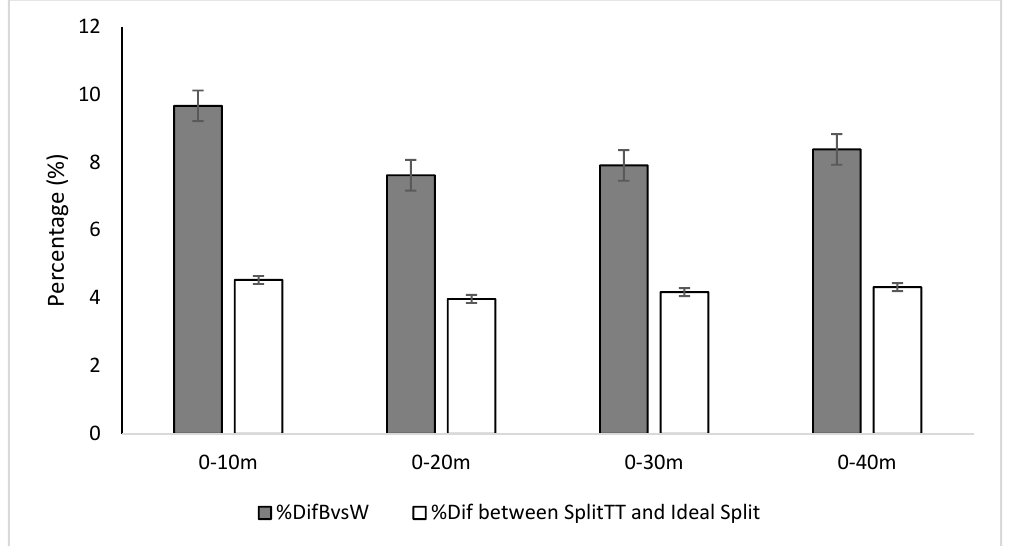
Figure 4. The %DifBvsW: Percentage difference between the best time compared to the worst time to run a specific split, %Dif between Split TT and Ideal Split: Percentage difference between the time to run a specific number of splits and the time if these splits were run as the best of them. Significant di ff erence compared to 0 − 10 m ( p < 0.05).